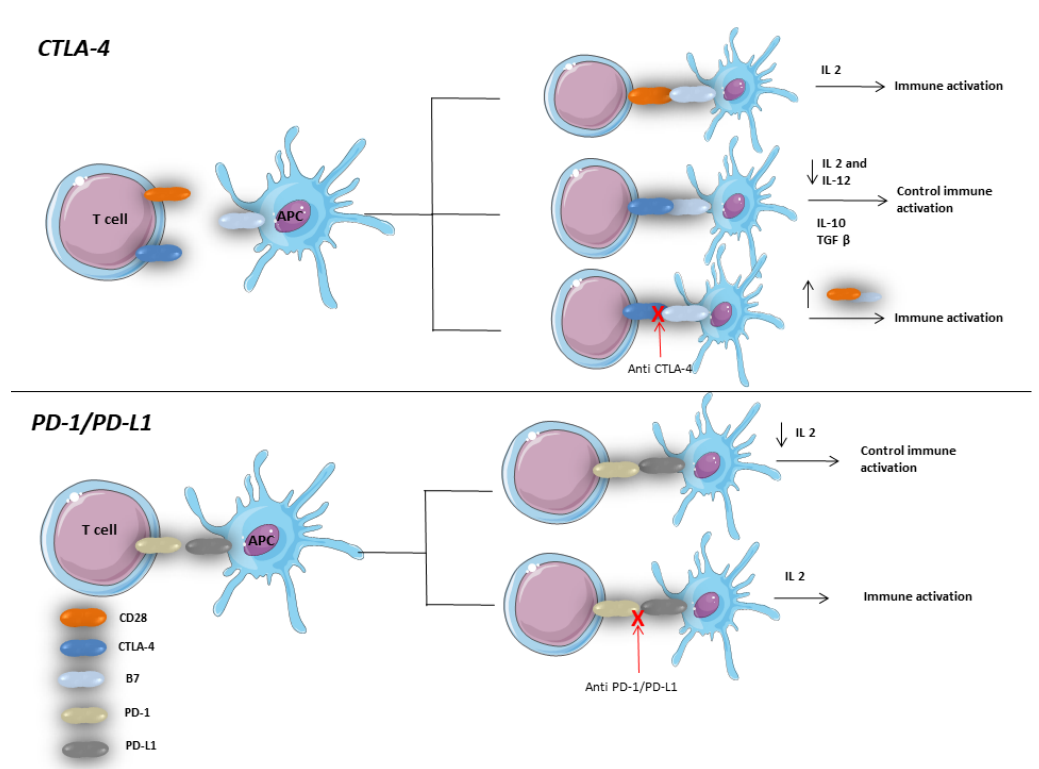
Figure 3. Role of CTLA-4 and PD-1 / PD-L1 pathways in immune response regulation in gastrointestinal tract. APC: antigen-presenting cells.Both CD28 and CTLA-4 compete with each other for a binding site (B7) on the surface of APC. Binding of CD28 to B7 is associated with induction of immune response through upregulation of production of IL2. On the other side, CTLA-4 B7 binding regulates the late immune response by decreasing IL2 [71]. Therefore, inhibition of CTLA-4 by antiCTLA-4 antibodies was found to be associated with an exaggerated immune response which might lead to colitis [85,86]. PD-1 / PD-L1 binding leads to immune response regulation through PI3K and AKT pathways. Therefore, inhibition of this binding might lead to immune response dysregulation which might lead to colitis and autoimmune exacerbation